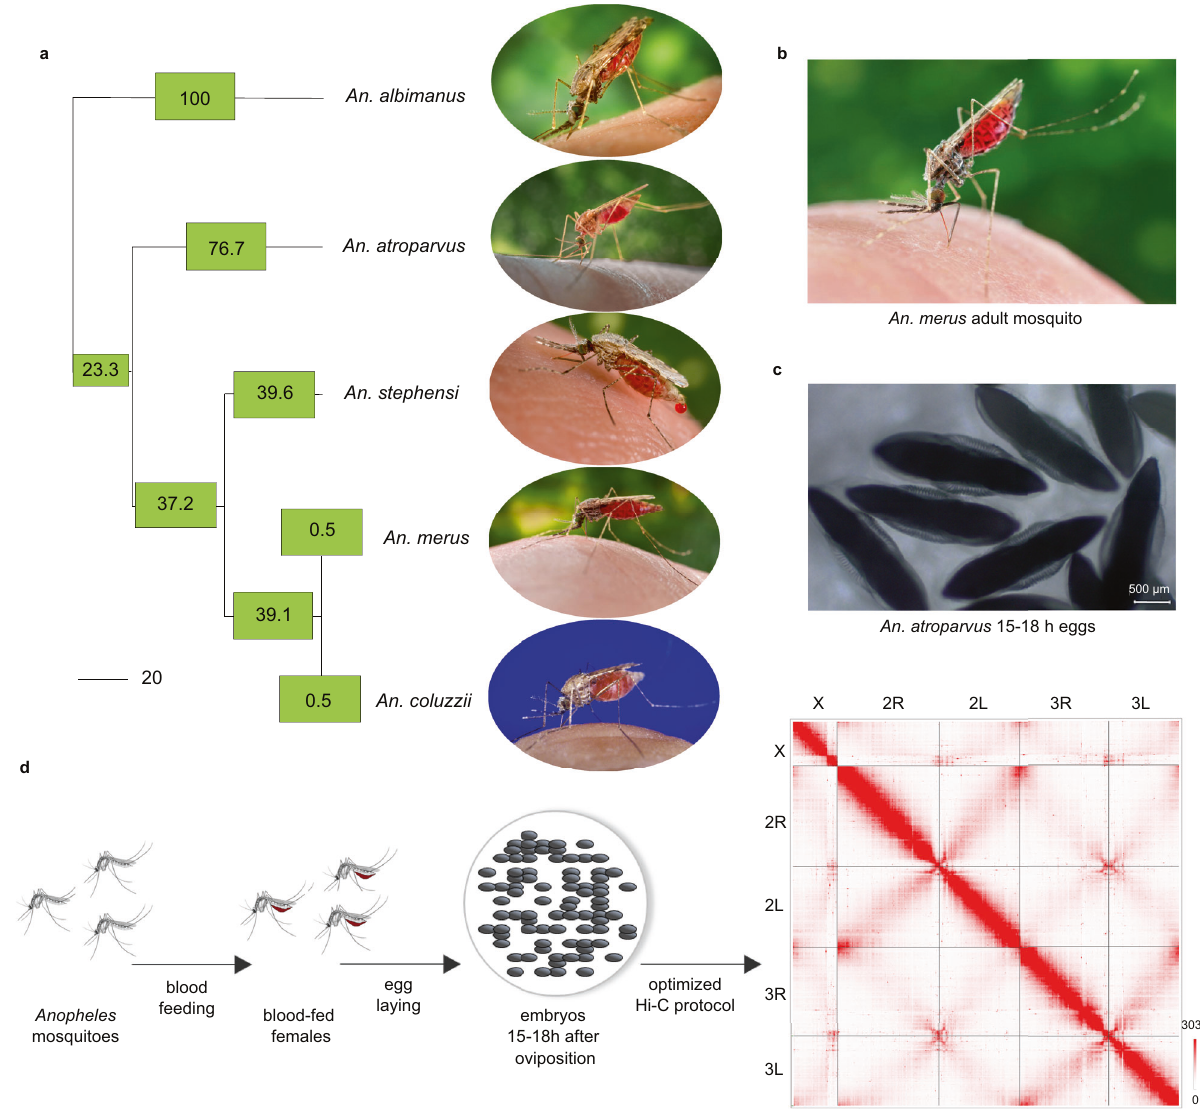
Fig. 1 Selected species and Hi-C experimental setup. a A time-calibrated phylogenetic tree shows estimated evolutionary distances among the selected Anopheles species; numbers in boxes show divergence times in millions of years (MY) for each branch; the scale bar represents 20 MY; b An. merus adult female mosquito; c An. atroparvus embryos at the 15 – 18 h developmental stage; d The experimental design of the Hi-C experiments using mosquito embryos, color bar re fl ects the contact frequency. Adult mosquito photo credit: CDC/James